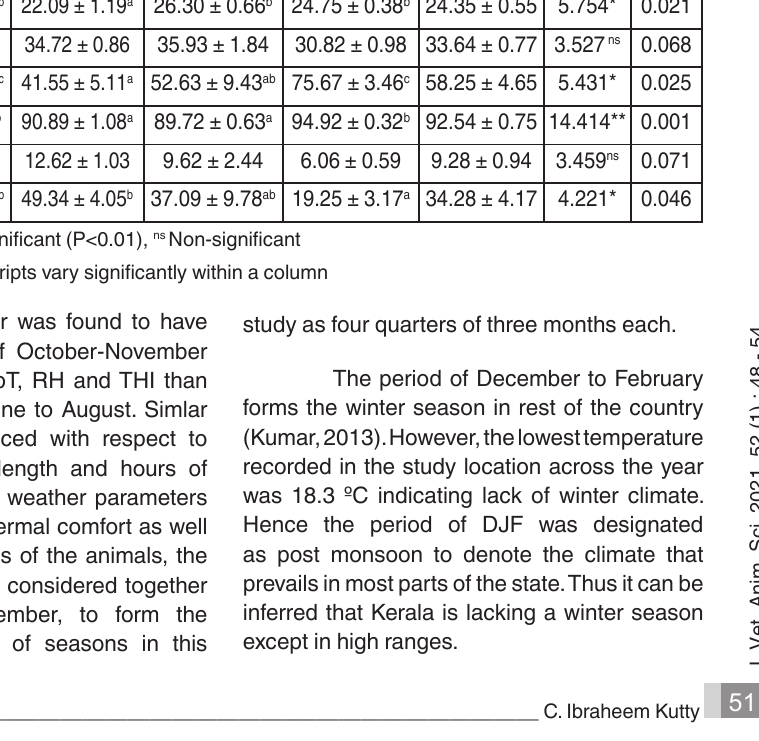
table 3. Quarterly mean ± SE of maximum and minimum temperature and relative humidity and the extent of variations between seasons Weather parameters